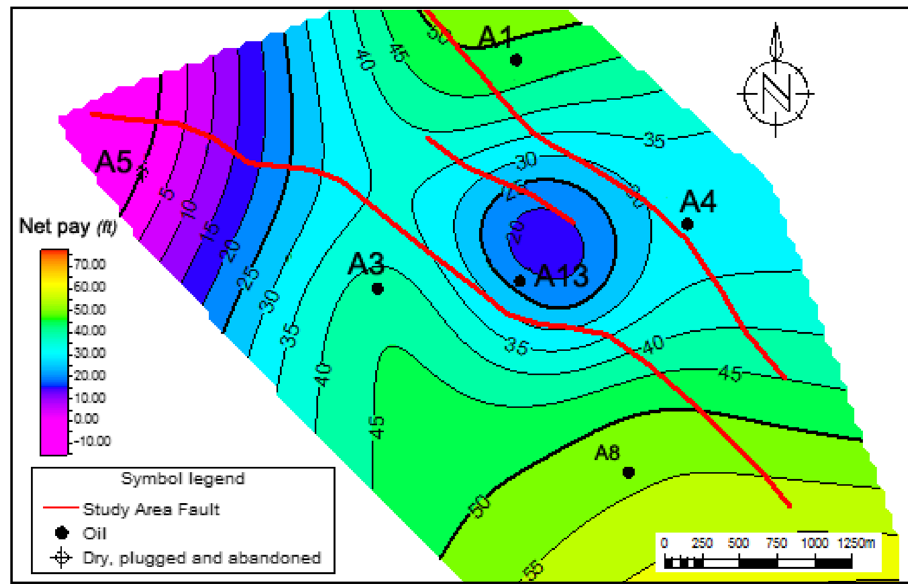
Fig. 17 Average net pay thick- ness of the Facha reservoir in the study